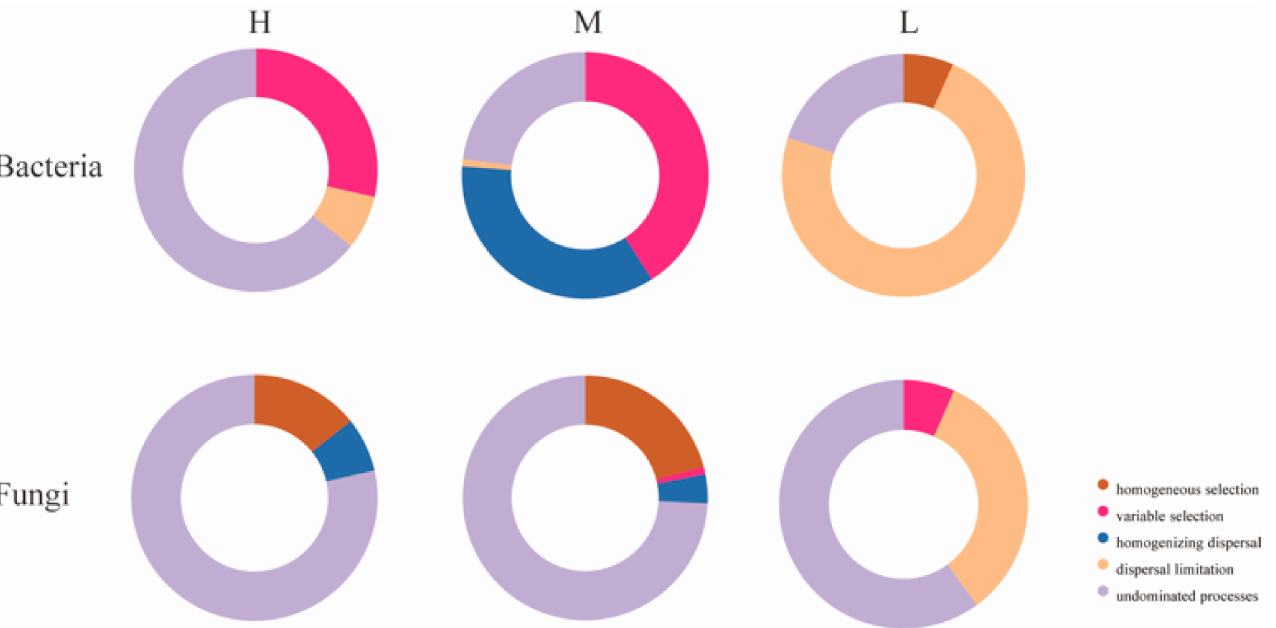
Figure 11. Contribution of each community assembly process under different water-salt gradients.